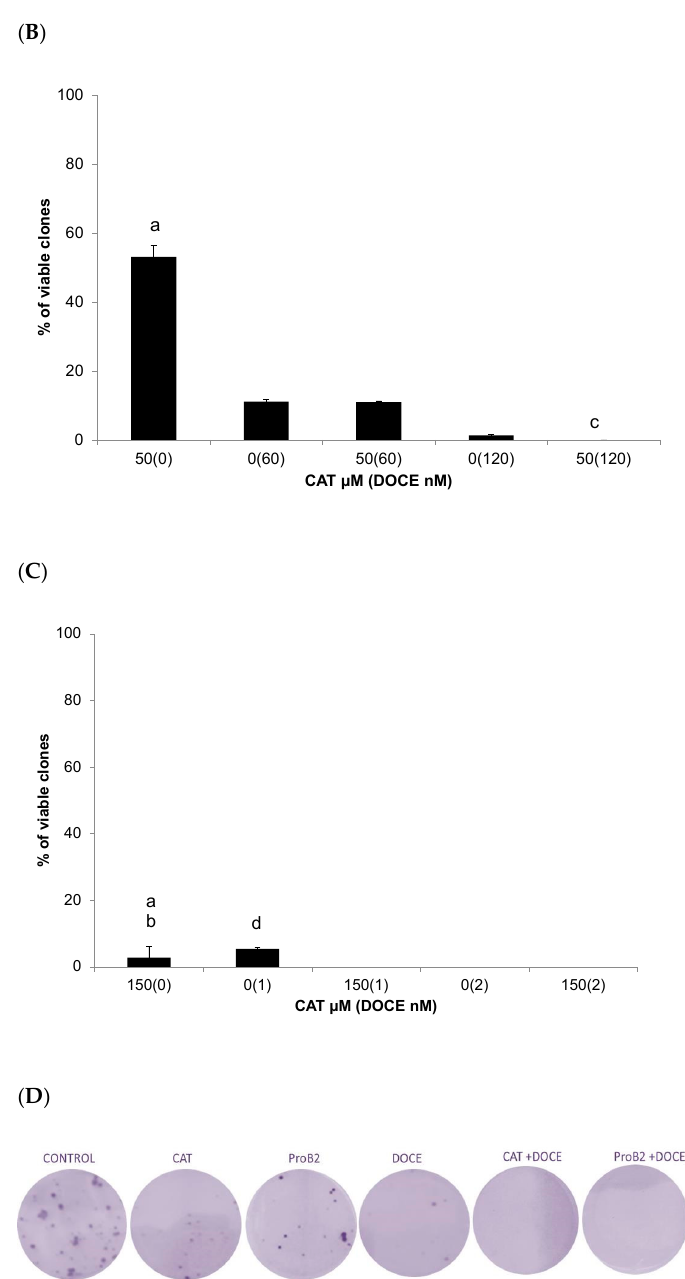
Figure 9. Effect of the treatments for 14 days on the clonogenic activity MCF-7 cells and DU145 cells. Clonogenic assay of MCF-7 cells treated with: ( A ) ProB2, DOCE or ProB2/DOCE combination or ( B ) CAT, DOCE or CAT/DOCE combination. ( C ) Clonogenic assay of DU145 cells treated with CAT, DOCE or CAT/DOCE combination. ( D ) Representative images depicting colony formation for MCF-7 cells treated with 50 µ M CAT, 50 µ M ProB2, 120 nM DOCE, 50 µ M CAT+120 nM DOCE or 50 µ M ProB2+120 nM DOCE. Clonogenic assay was performed as described in material and methods. Columns, mean; bars, SE ( n = 3). a represents the significant difference between CAT or ProB2 treatment alone and control treatment; b represents the significant difference between CAT or ProB2 treatment alone and low-dose DOCE; c represents the significant difference between combination treatment (CAT + DOCE) and DOCE alone; d represents the significant difference between combination treatment (ProB2 + DOCE) and DOCE alone ( p < 0.05; one-way ANOVA). Abbreviations: CAT, catechin; DOCE, docetaxel; ProB2, procyanidin B2.